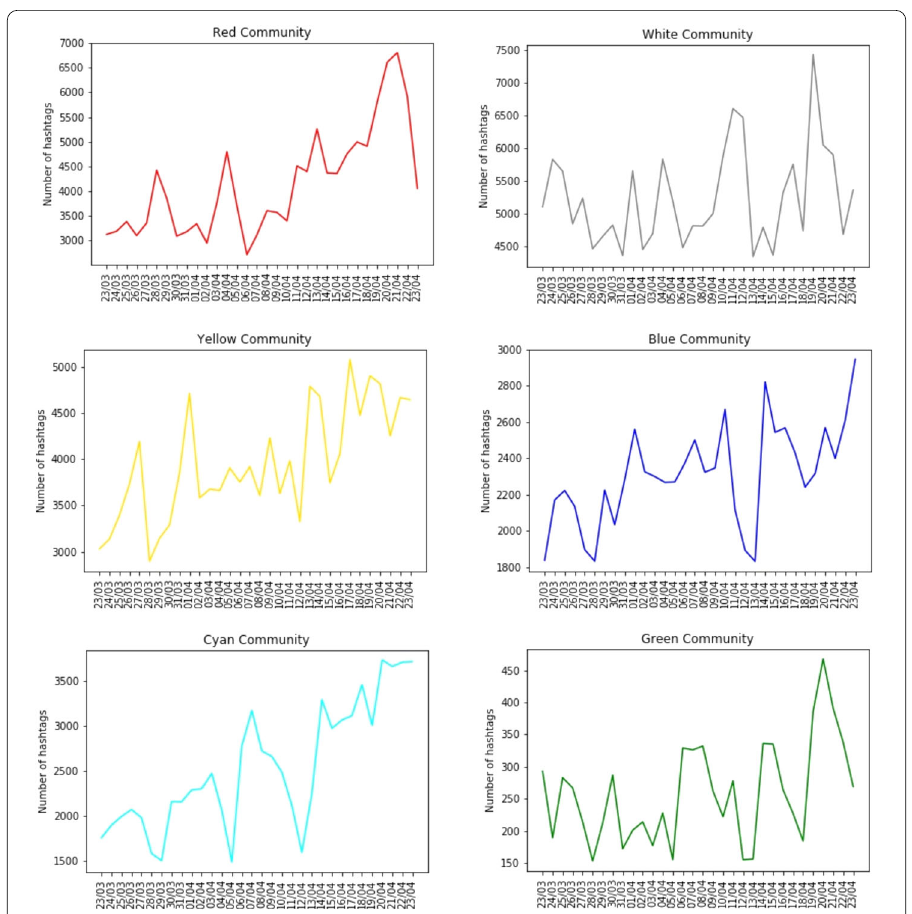
Figure 5 Temporalevolutionofthenumberofhashtagsshareddaytodayandbelongingtoeachcommunityin